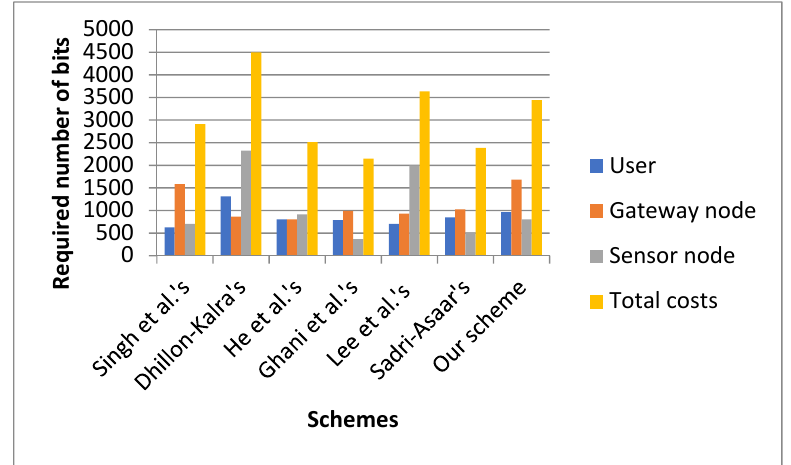
Figure 14. Comparison of communication cost .